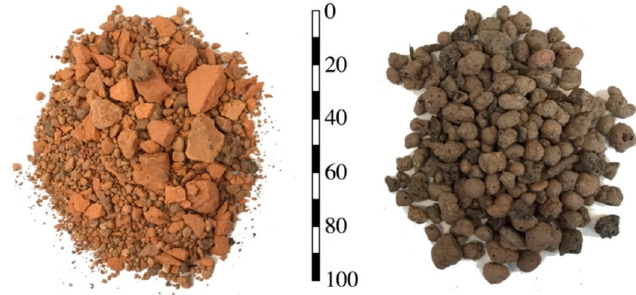
Figure 1. ( Left ) crushed brick-based substrate (BBS); ( right ) light expanded clay aggregate-based substrate (LECA). The scale is in mm.